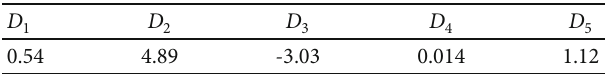
Table 6: Parameters of the Johnson-Cook damage model for the bullet jacket material.